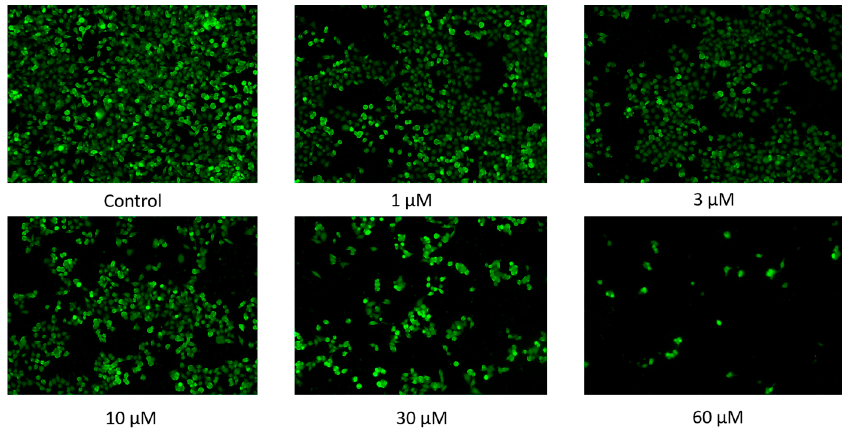
Figure 3. E ff ect of PYR26 on the ROS of cells. Figure 3. Effect of PYR26 on the ROS of